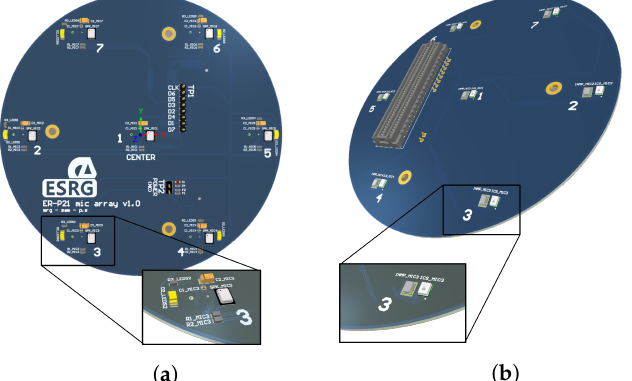
Figure 3. Three-dimensional (3D) view of the PCB microphone array with the microphone position (numbered 1 to 7). ( a ) Top-view. ( b )